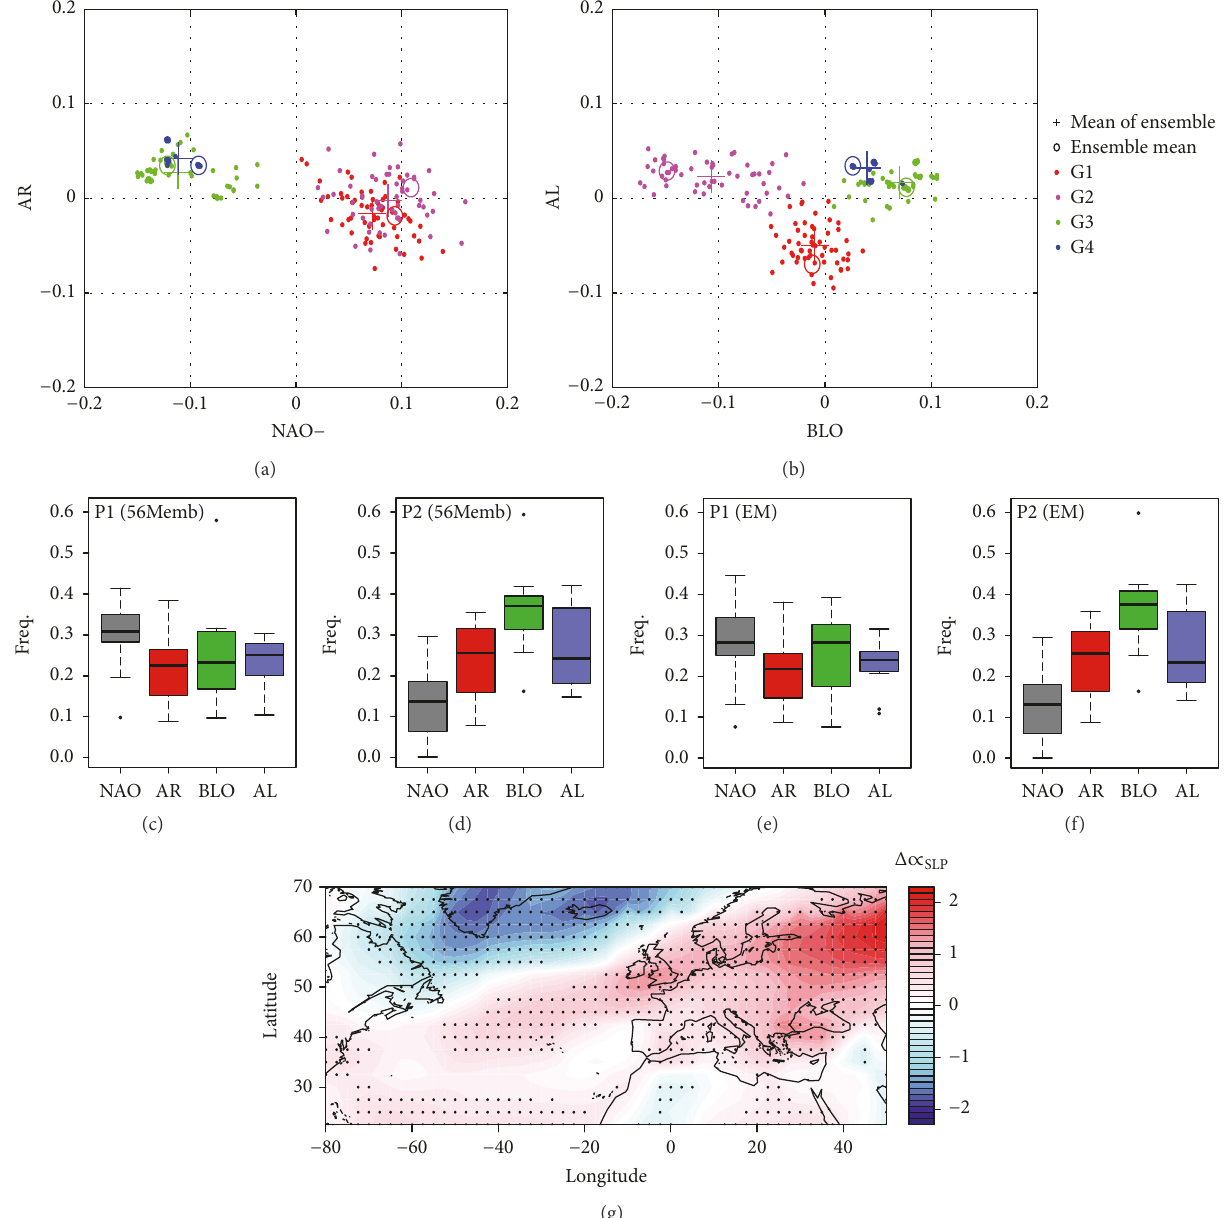
Figure 4: Changes in the dynamical representation of the warmest summers. (a, b) Average correlations of warmest summers with respect to the 4 weather regimes (black circle on 𝑥 -axis in Figure 3), points represent each member, crosses represent the mean of all the 56 members, and circles represent the EM. Colors represent the 4 groups of summers (G1 red, G2 purple, G3 green, and G4 blue). In (c)–(f), boxplots show frequencies of the 4 weather regimes classified in two periods: (c, e) for summers before 1930 (groups G1 + G2) and (d, f) for summers after 1930 (groups G3 + G4), for all the 56 members (c, d) and the EM (e, f). (g) shows the difference in the SLP mean between those two periods (after 1930 and before 1930). Points represent significance at 95 percent after the performance of a Monte Carlo